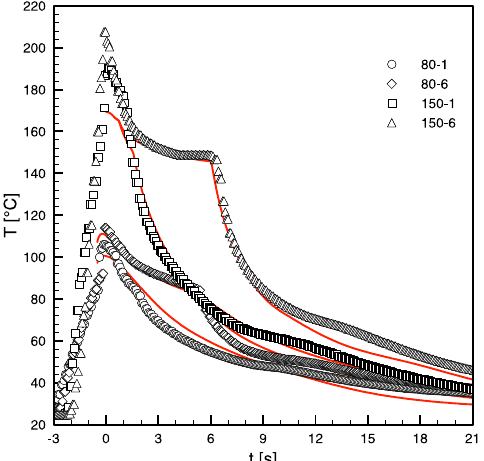
Figure 1. Comparison between experimental (symbols) and simulated (red full lines) cavity surface temperatures evolutions obtained for the tests 80-1, 80-6, 150-1 and 150-6.